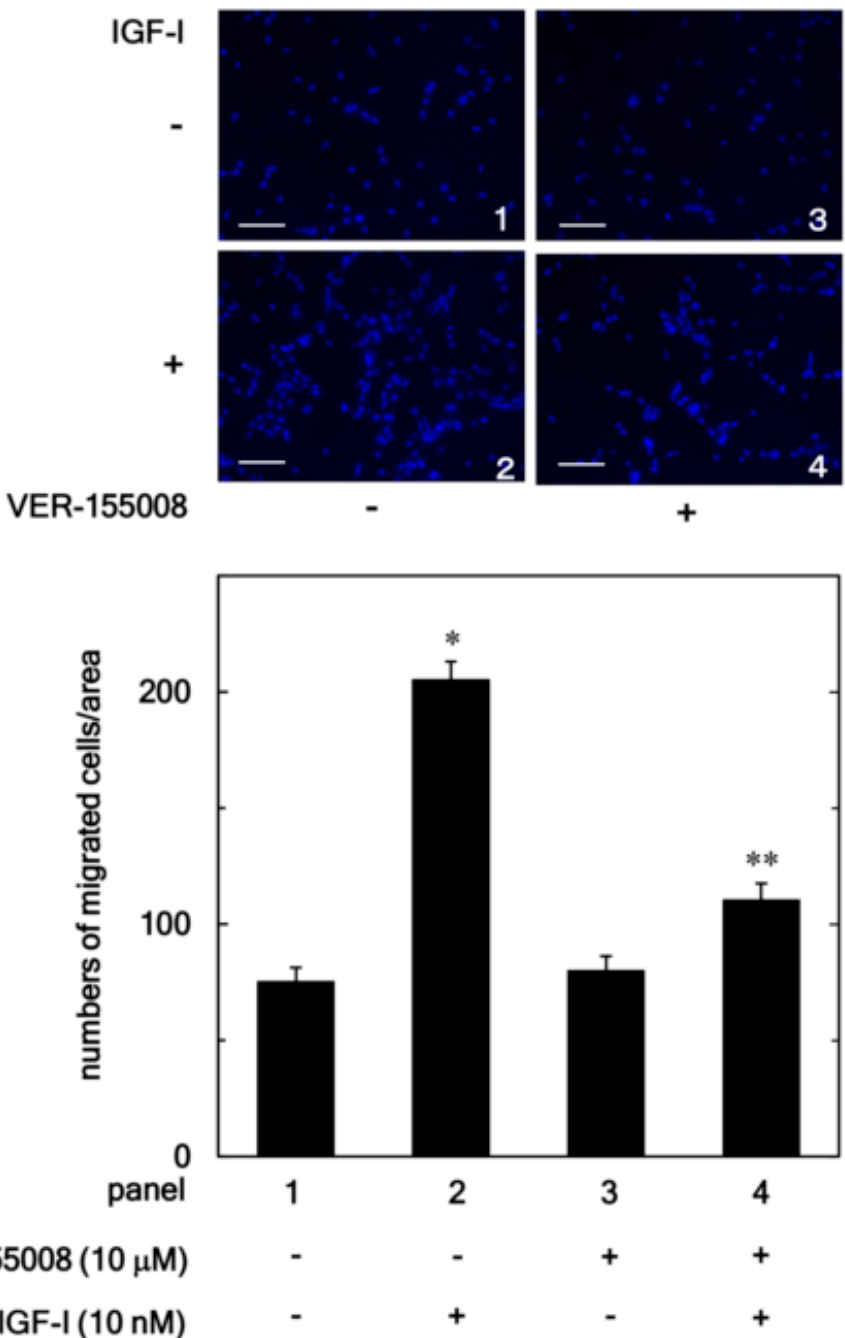
Figure 2. Effect of VER-155008 on the IGF-I-induced migration of MC3T3-E1 cells. The migration was evaluated by using a Boyden chamber. The cells were pretreated with 10 µM of VER-155008 for 60 min and then stimulated by 10 nM of IGF-I or vehicle for 16 h. The representative photographs from triplicate independent experiments and the histogram showing the numbers of migrated cells in each panel are presented. The blue spots indicate nucleus of migrated osteoblast stained by DAPI. * p < 0.05 compared to the value of the control cells without IGF-I stimulation. ** p < 0.05 compared to the value of IGF-I alone. Scale bar: 100 µm.